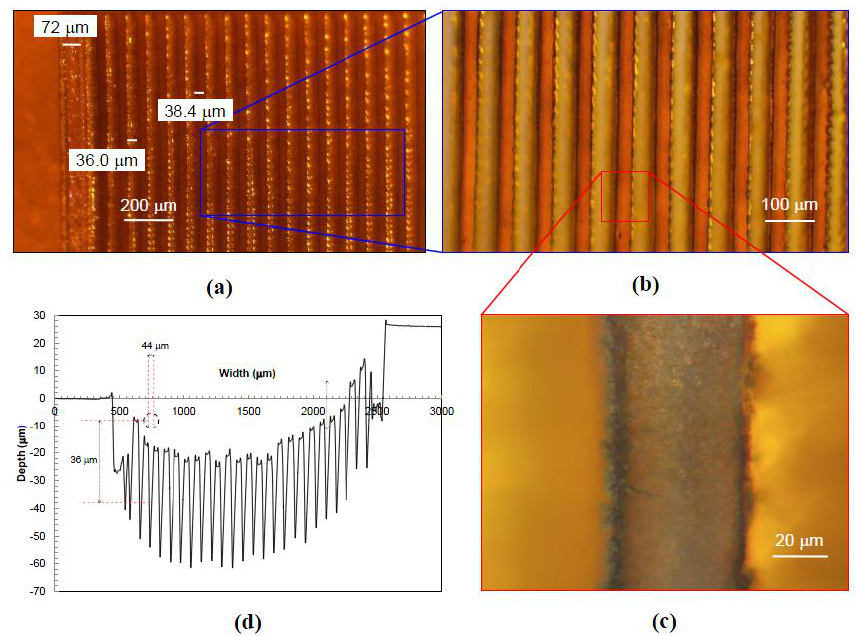
Figure 3. Foil strain gauge substrate with grooves oriented at 0°. ( a ) Optical image of substrate including one border for the electrode; ( b ) Close-up optical image of substrate; ( c ) Close-up optical image of a single groove; ( d ) Profilometer data indicating the width and depth of each groove.